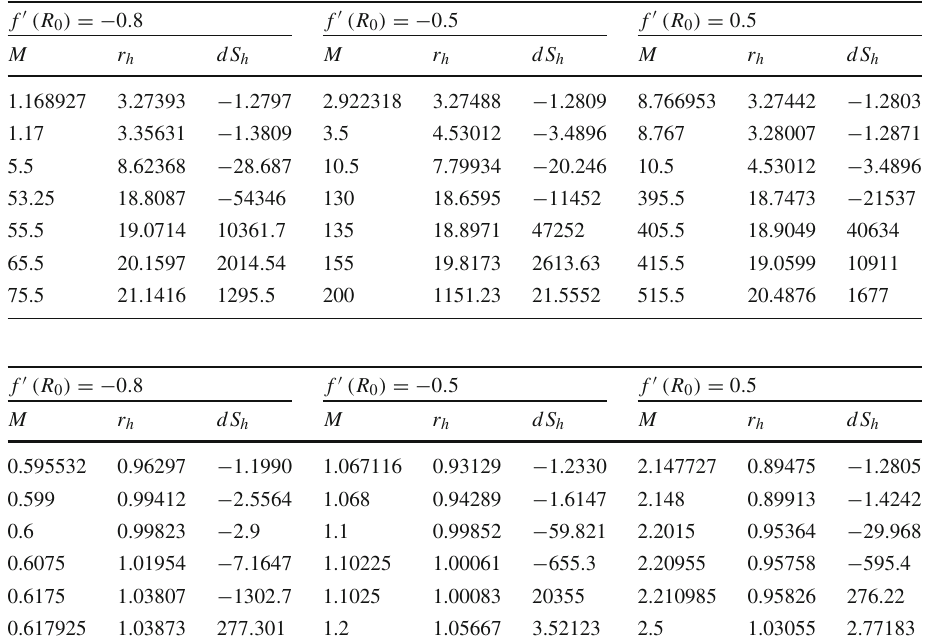
Table 4 The relation between dS h , M and r h of p = 1